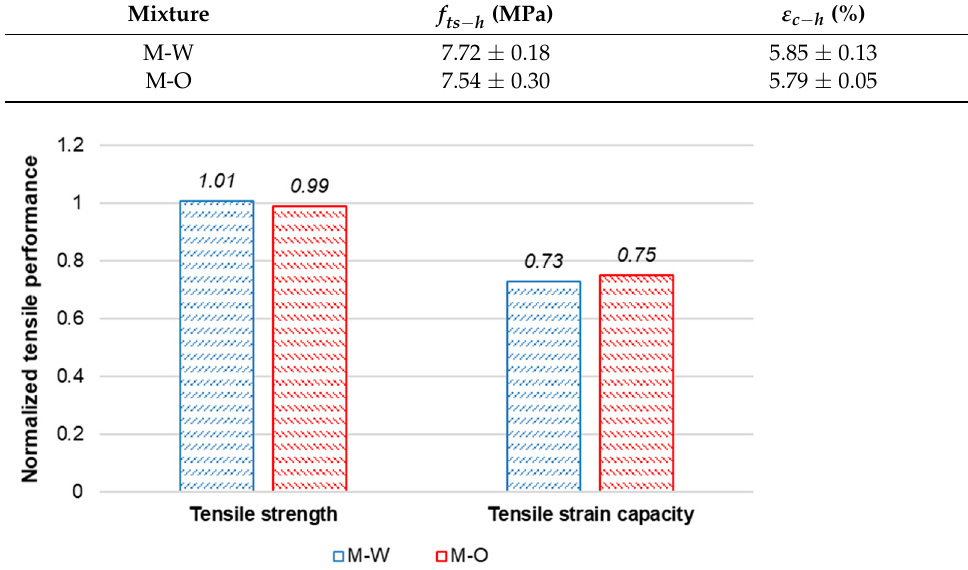
Figure 11. Normalized tensile properties after crack-healing.